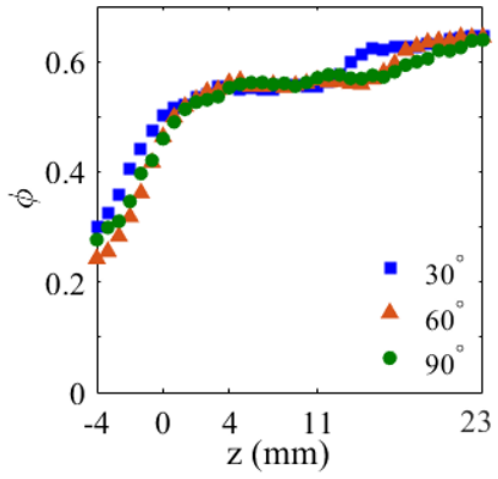
Fig. 5. The solid fraction profiles along the centreline of the